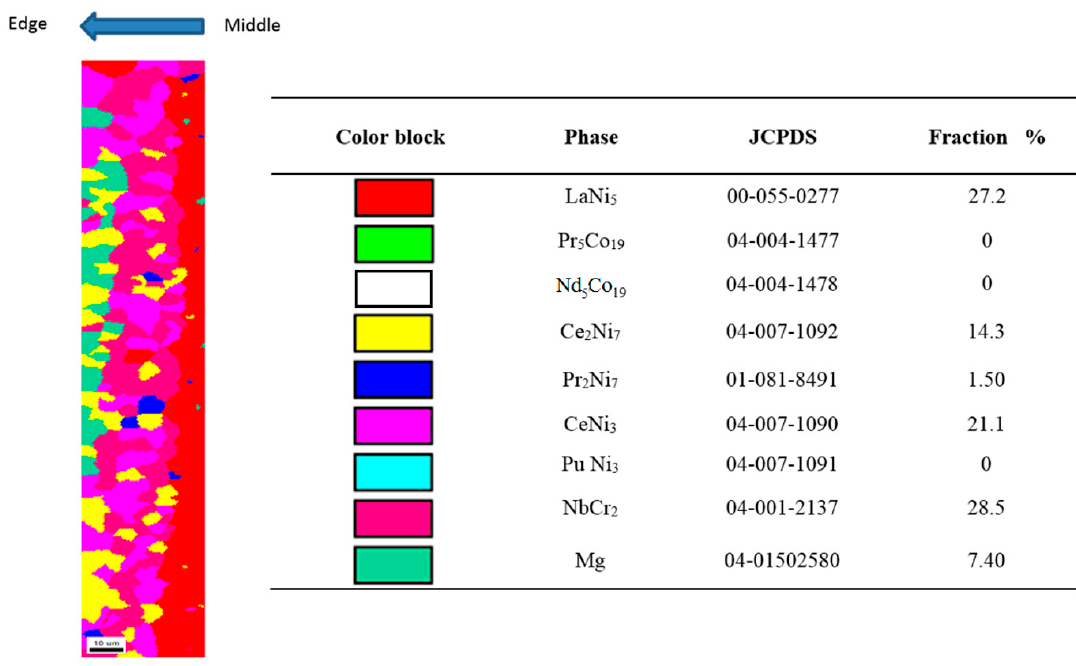
Figure 7. EBSD phase identification mapping and quantification of the 16-h annealed sample. The grain tolerance angle is 15°, and the minimum grain size is 3 µm.